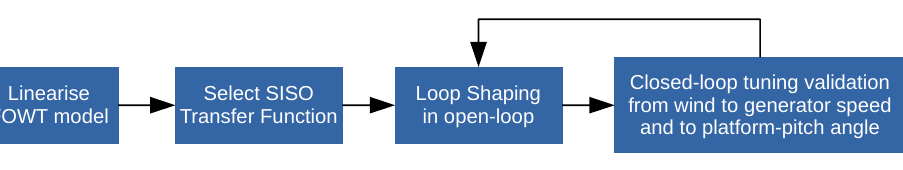
Figure 4. Process carried out for the APS and WR control loops manual